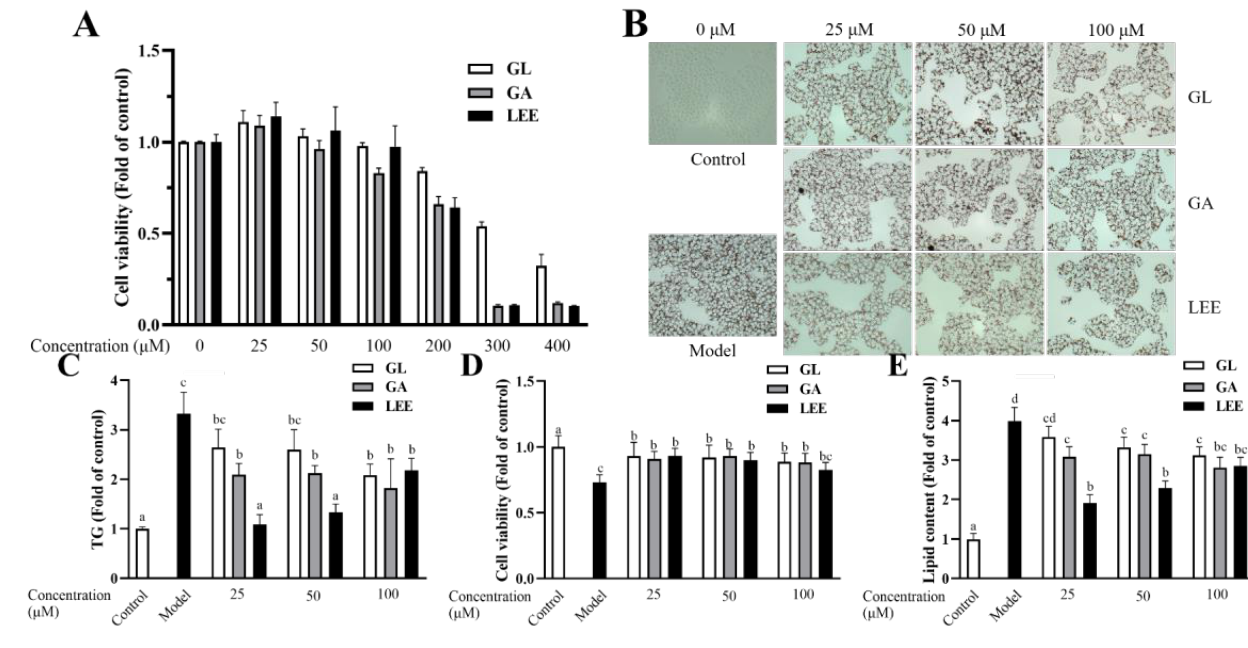
Figure 10. Effects of GL, GA and LEE on FFA-induced HepG2 cells. ( A ) Cell viability of HepG2 cells. ( B ) Oil Red O staining of FFA-induced HepG2 cells (400 × ). ( C ) Intracellular TG levels. ( D ) Cell viability of FFA-induced HepG2 cells. ( E ) Intracellular lipid levels. The results are expressed as the means ± SEM of three independent experiments. Different letters indicate significant differences in the mean values ( p < 0.05).